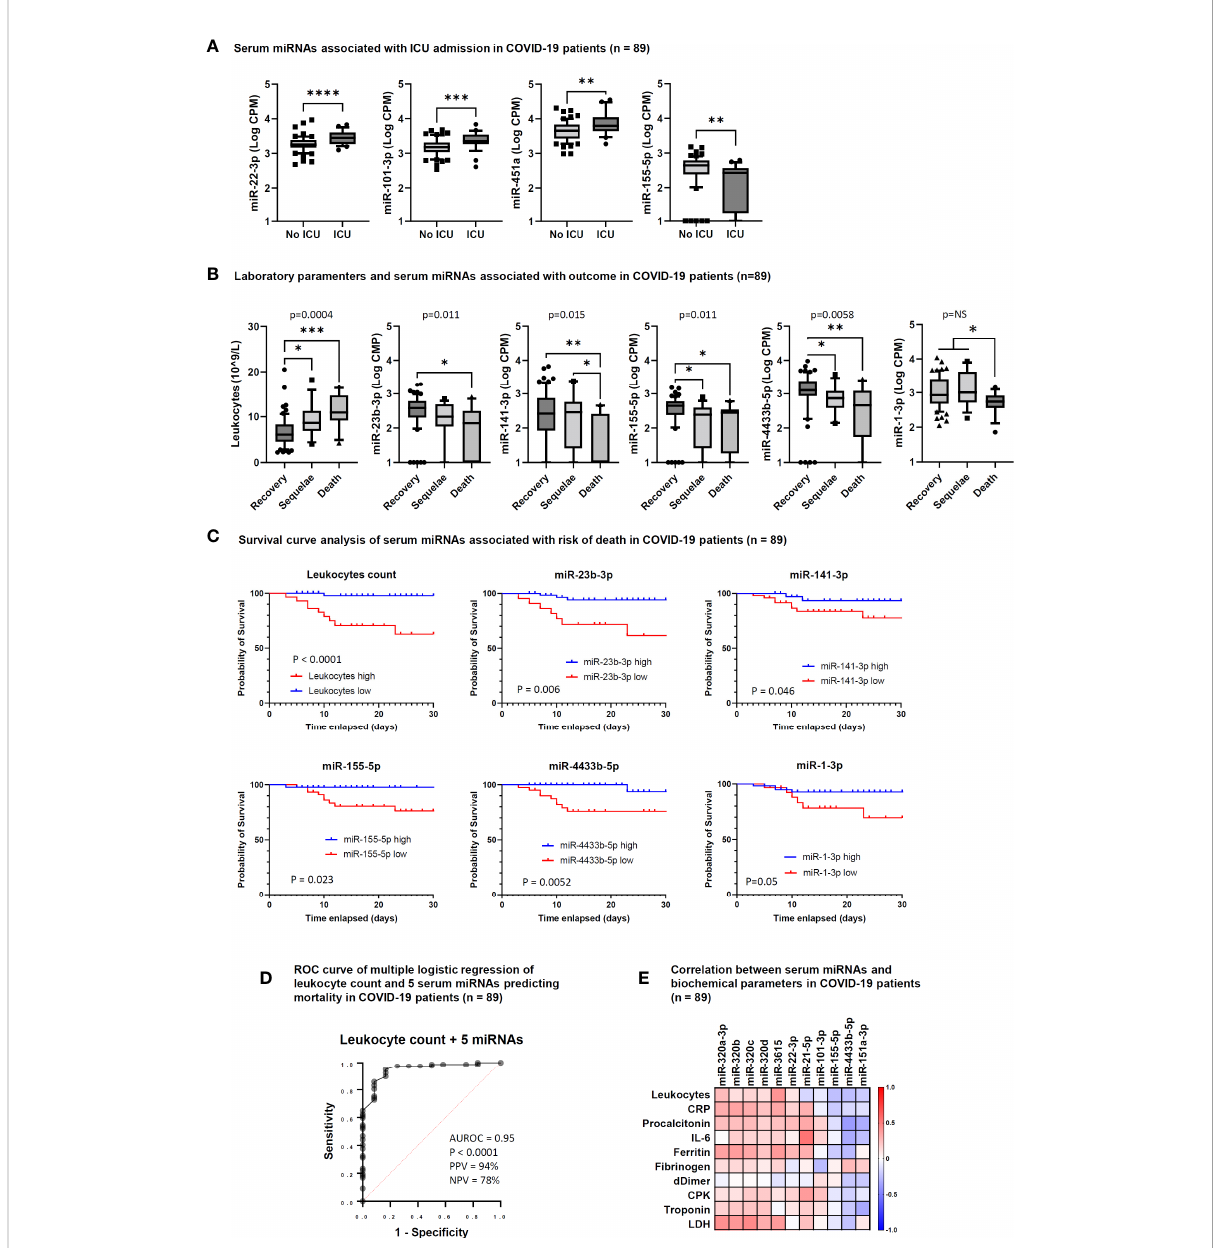
FIGURE 4 Serum microRNAs associated with intensive care unit (ICU) admission and outcome in COVID-19 patients. (A) Box and whiskers plot of differentially expressed (DE) miRNAs between COVID-19 patients hospitalized at ICU (ICU, n = 28) and not hospitalized at ICU (No ICU, n = 61). Wishers represent 10-90 percentile; p values indicated by * were determined by unpaired Mann Whitney test. (B) Box and whiskers plot of leukocyte counts and DE miRNAs among COVID-19 patients who recovered (Recovery, n = 61), showed COVID-19-related sequelae (Sequelae, n = 16) or had died (Death, n = 12) by day 90 after hospitalization. Wishers represent 10-90 percentile; p values indicated by * were determined by Kruskal Wallis test for multiple comparisons, considering two stage linear step-up procedure of Benjamini, Krieger and Yekutieli adjusted p- values ≤ 0.05. One-way ANOVA p value results of comparisons among the three groups are shown in the graphs. (C) Survival curve analysis of serum miRNAs signi fi cantly associated with the risk of death at 28 days after hospitalization. Comparisons between groups were made by Log- rank test or Gehan-Breslow-Wilcoxon test. P values are shown in the graphs and statistical signi fi cance was de fi ned by p <0.05. Cut-off values for low and high miRNA levels in serum were determined by ROC curve analysis. (D) Candidate miRNA biomarkers to predict the risk of death in COVID-19 patients. P value and receiver operating characteristic (ROC) curve were calculated by multiple logistic regression analysis. AUROC, area under the ROC curve; PPV, positive predictive power; NPV, negative predictive power. The fi ve serum miRNAs include miR-1-3p, miR-23b- 3p, miR-141-3p, miR-155-5p, and miR-4433b-5p. (E) Correlation matrix between serum miRNAs and laboratory parameters in COVID-19 patients (n = 89). The heatmap represents Spearman r values of miRNAs showing one or more statistically signi fi cant correlation with any laboratory parameter. *p<0.05; **p<0.01; ***p<0.001;